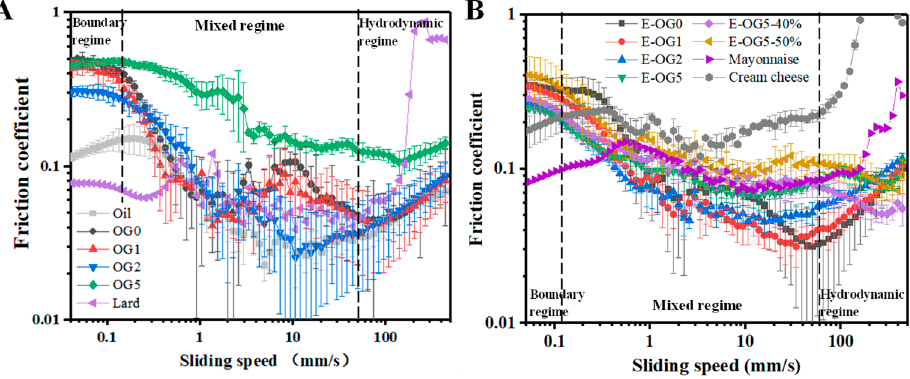
Figure 8. Stribeck curves were obtained for corn oil and oleogel ( A ) and emulsions ( B ).